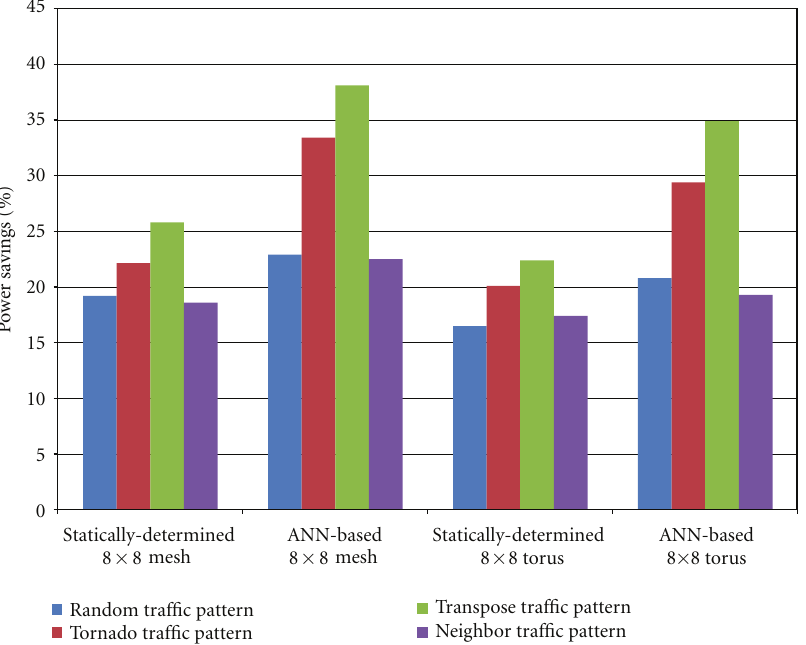
Figure 9: Power Savings for 8 × 8 mesh and 8 × 8 torus networks for the ANN-based technique, static threshold technique and no on/o ff